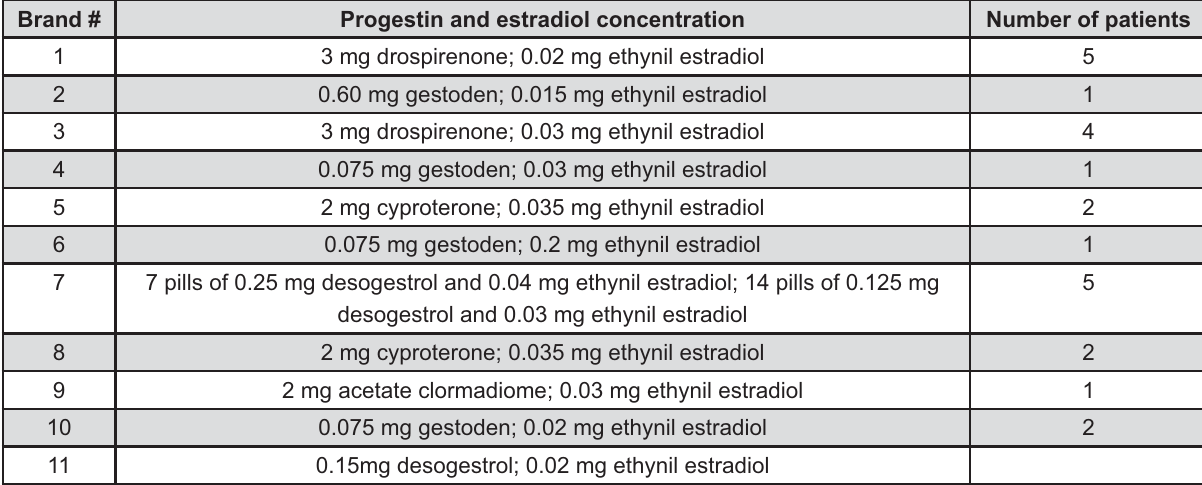
Table 1- Clinical periodontal parameters in the test and control groups (unpaired t test)